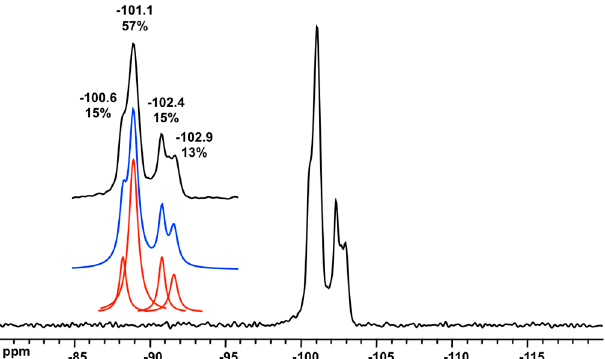
Figure 7. 29 Si MAS NMR spectrum of D6R@ α -CD. Inset: spectral decomposition showing four sites in a 1:3:1:1 ratio.